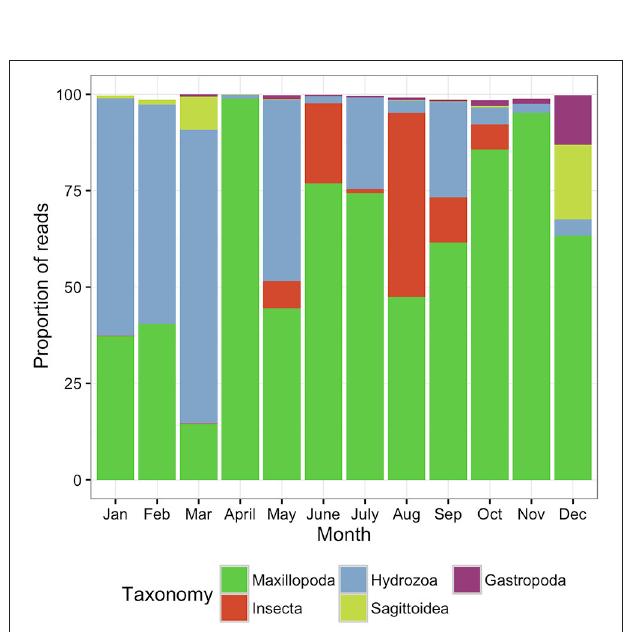
FIGURE 3 | Metazoan composition of the samples collected using the MANTA net, trawled only at the offshore station. Proportion of reads produced by the MANTA samples assigned to metazoan taxa at the class level showing the monthly trends for 1